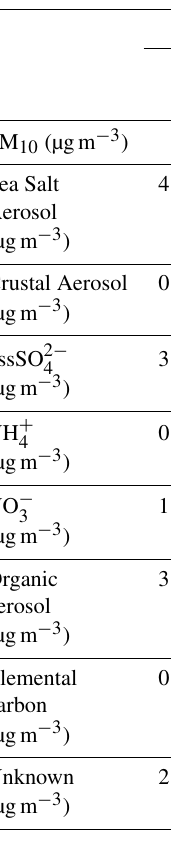
Table 2. Mean and standard deviation of PM 10 load and composition, and percentage with respect to PM 10 (in brackets) at Lampedusa and Capo Granitola. Mean, standard deviation and percentage are calculated on homogeneous data sets for both sites, considering all the common sampling (“all data” columns) and excluding the mistral events (“mistral excluded” columns).